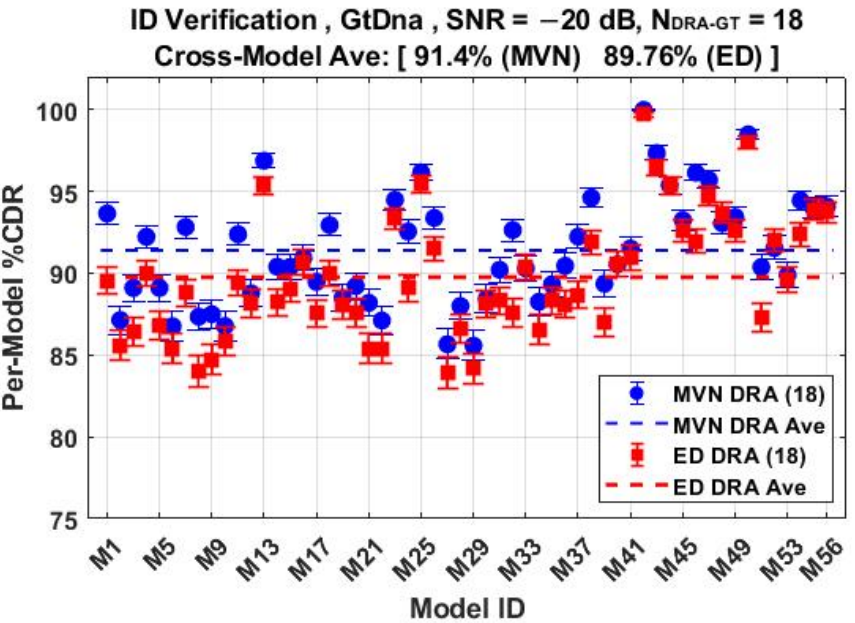
Figure 18. Per-model ID verification performance for jointly selected N DRA-GT = 18 features using the N Mdl = 56 MDA models used for generating %C results in Figure 14. Results generated under SNR = − 20 dB conditions using ED ( ■ ) and MVN ( ● ) measures of similarity.